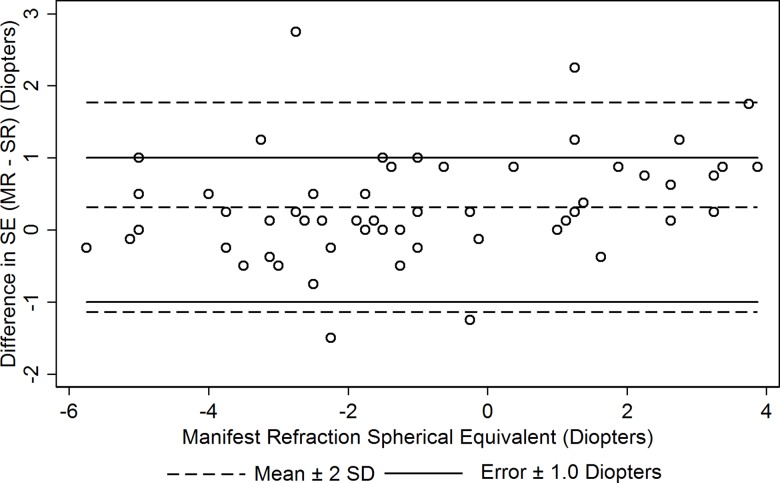
Modified Bland Altman (Difference in SE (MR SE minus SR) vs. MR SE) for right eye.Abbreviations: SE = spherical equivalent, MR = manifest refraction, SR = self-refraction.